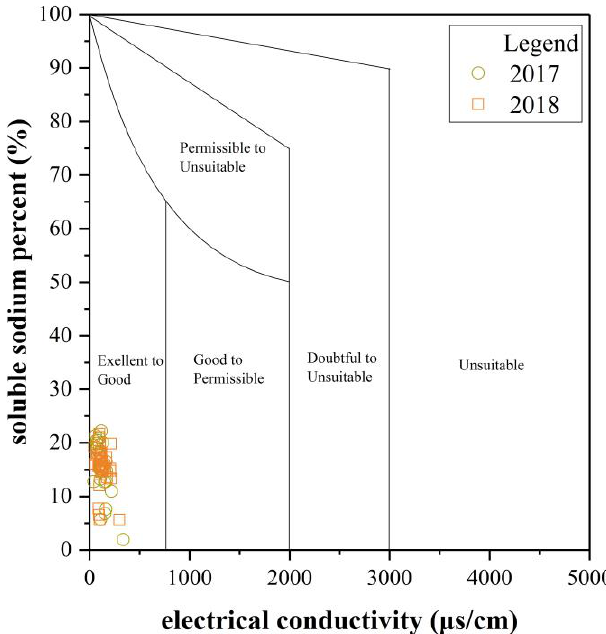
Figure 8. Wilcox diagram for evaluating the suitability of water for irrigation [50] .